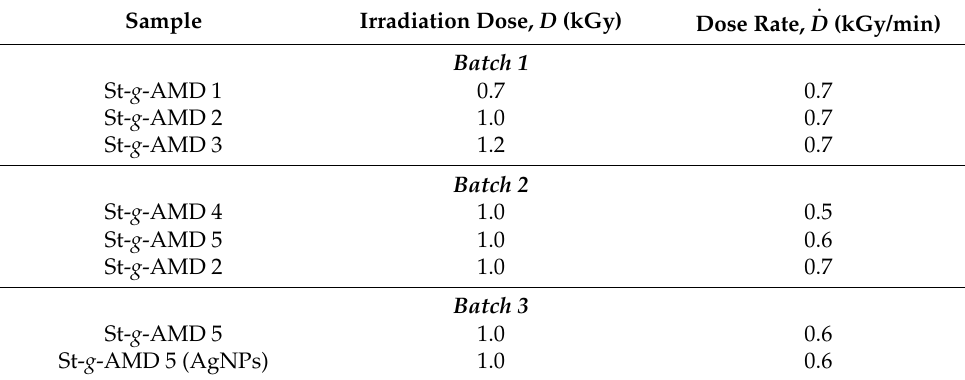
Table 2. Synthetic details of the irradiations and sample